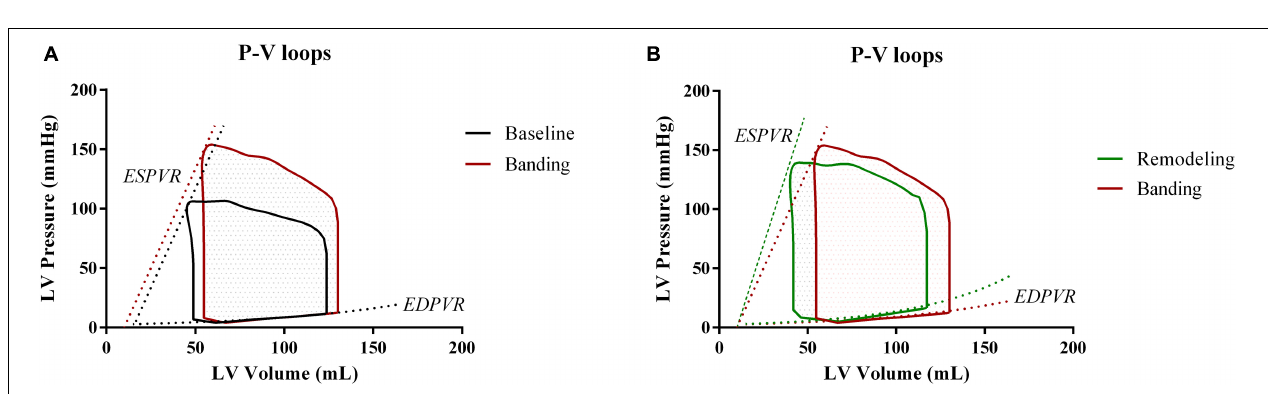
FIGURE 2 | Simulation setup for the three hemodynamic states. (A) Schematic representation of the arterial tree, taken from Reymond et al. (2009) and reproduced with permission. (B) Simulation of aortic banding. (C) Simulation of LV remodeling. TPR, total peripheral resistance; Pfill, filling pressure; Ees, end-systolic elastance; β , diastolic stiffness.